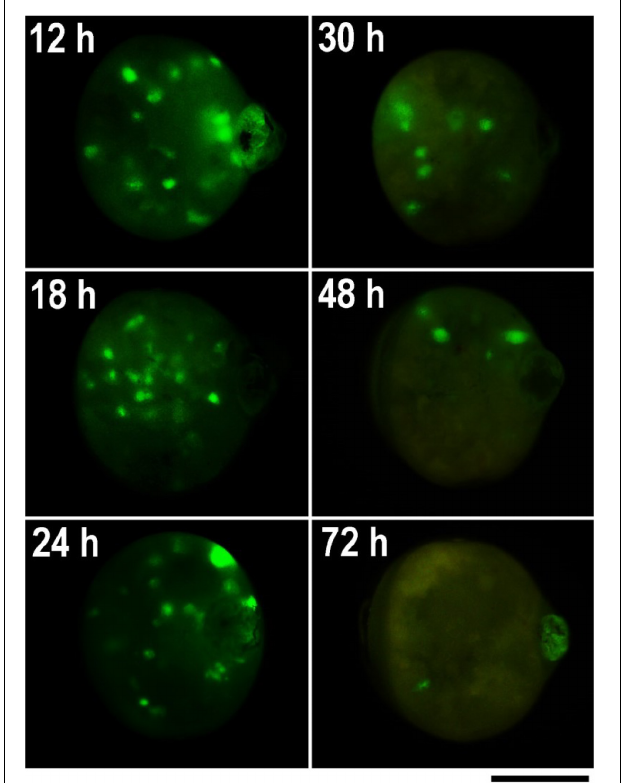
FIGURE 4 | GFP expression in parthenogenetic embryos of B. mori 1–31 incubated at 15 ◦ C illustrating efficiency of microinjection at different developmental stages. The GFP-containing DNA plasmid was injected into the heat-shock-activated eggs during the first 72 h AEA in times specify by numbers in each figure. GFP expression was examined 4 days before hatching. Time AEA is indicated by the inset numbers. Scale bar: 500 µ m.